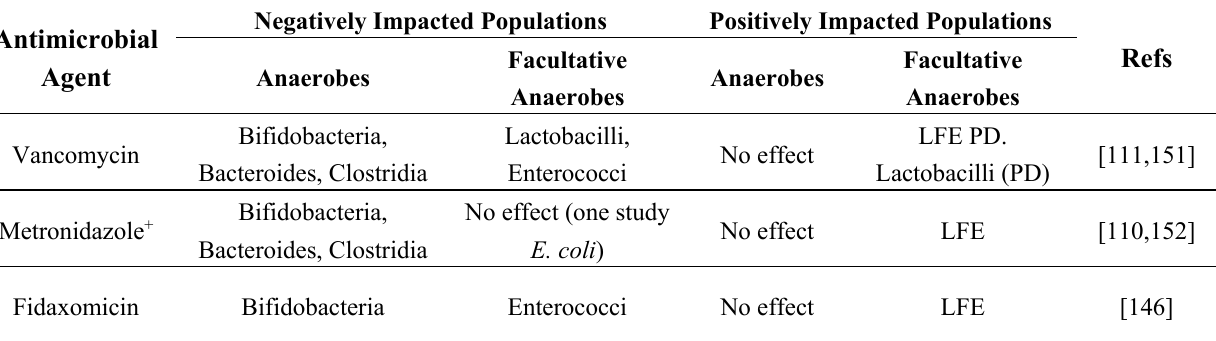
Table 3. Changes in selected indigenous gut microflora populations following exposure to CDI therapeutic antimicrobial agents in vitro and in